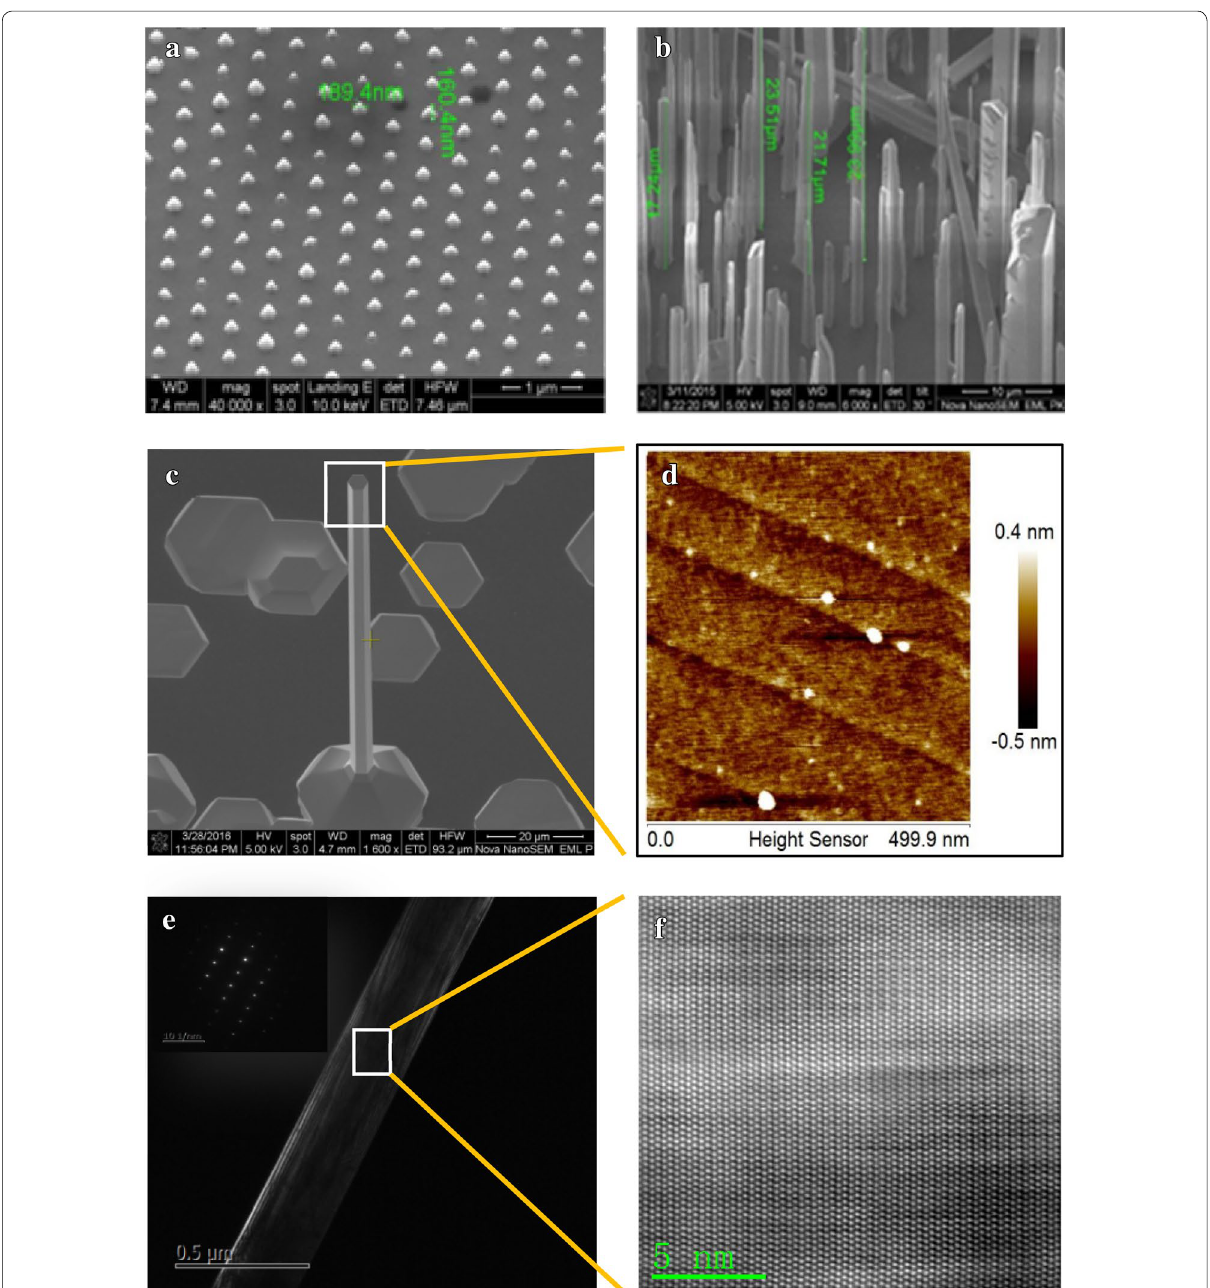
Fig. 1 Typical scanning electron microscope (SEM) images of GaN nanocolumns grown by a selection growth method and b self-organized method, c SEM image of the self-organized catalytic-free growth GaN nanocolumn, d AFM image of the top of the GaN nanocolumn, e transmission electron microscope (TEM) image and electron diffraction pattern, f high resolution TEM atomic